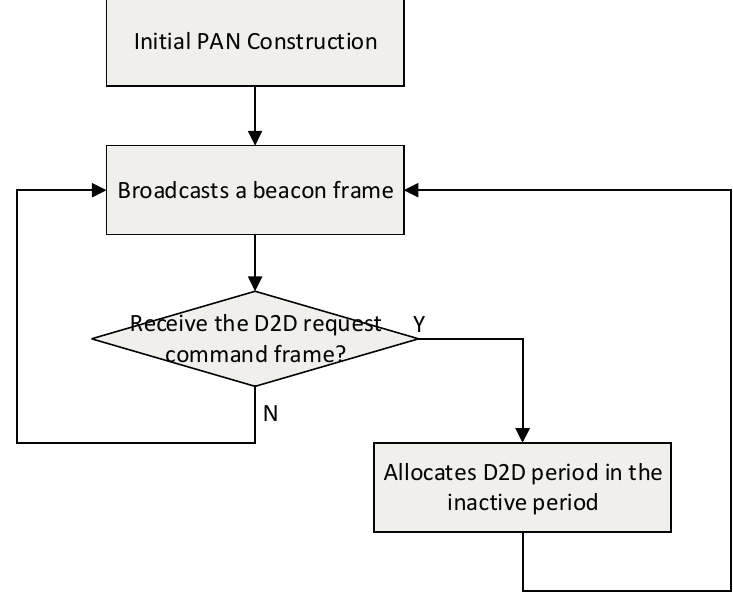
Figure 4. The flow chart of coordinator using the cooperative MAC